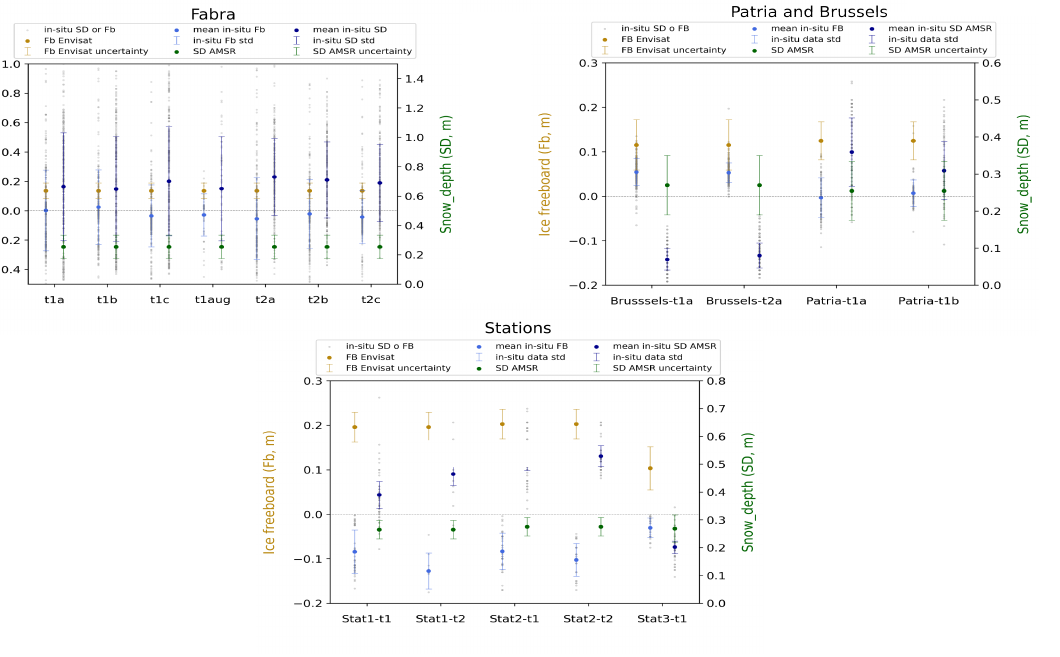
Figure A3. Comparisons between the sea ice freeboard and snow depth of SIMBA transects measure- ments with the Envisat sea ice freeboard and the AMSR snow depth data. For each transect the sea ice freeboards are presented on the first row, with values indicated on the left side Y-axis, and snow depths are presented on the second row, with values indicated on the right side Y-axis. The name of the transects are taken from Lewis et al. [31]. All the in-situ measures along the SIMBA transects are represented in grey with the mean value indicated in blue (clear blue for the ice freeboard and dark blue for the snow depth). the errorbars represent the ± standard deviation interval of the measurements. The range of uncertainties of the satellite data is also indicated by